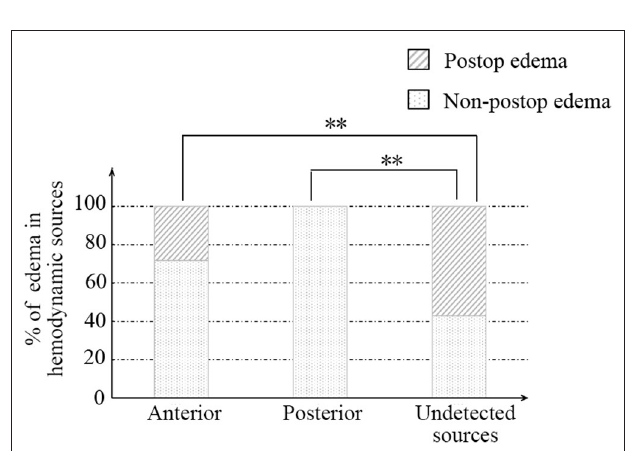
FIGURE 4 | The relationship between recipient hemodynamic sources and postoperative cerebral edema. ** indicates p < 0.01.